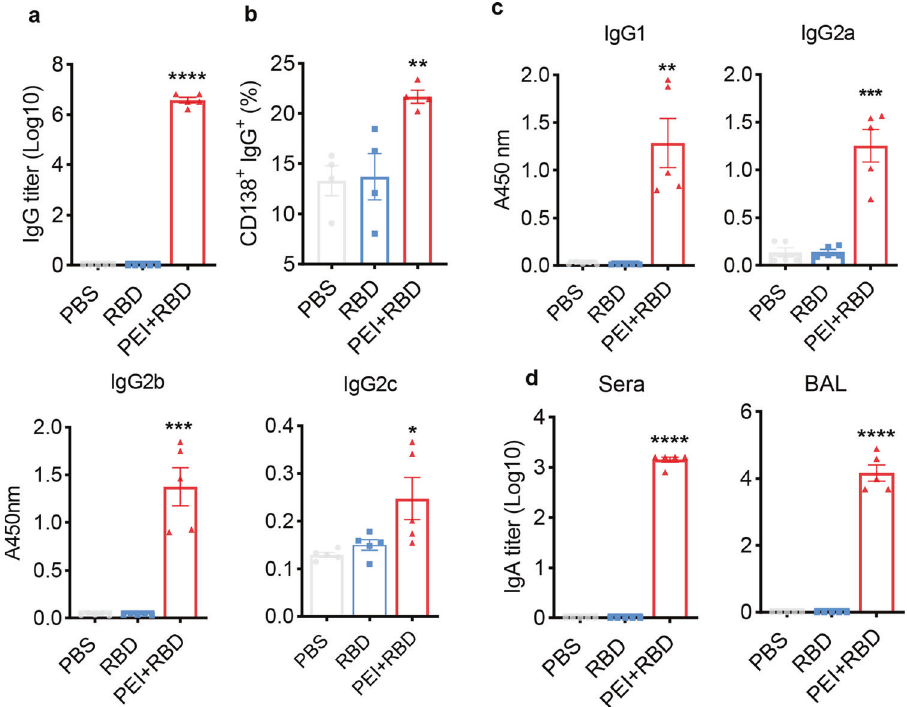
Fig. 1 Humoral responses in 1 year after intranasal immunization with RBD vaccine. NIH mice were intranasally immunized with PBS, RBD or PEI-adjuvanted RBD on days 0, 7, and 21. On day 365 after the fi rst dose, RBD-speci fi c antibodies in the serum and BALs were determined with ELISA. a RBD-speci fi c total IgG levels in the sera of immunized mice. b Frequency of IgG-secreting CD138 + long-lived plasma B cells in bone marrow of immunized animals on day 365, as determined by FCM. c Further analysis of RBD-speci fi c IgG isotypes in the serum, including IgG1, IgG2a, IgG2b, and IgG2c. d RBD-speci fi c IgA titers in the sera and BALs of immunized animals on day 365. All the data were presented as mean ± SEM. n = 4 – 5. P values were compared to PBS group (* P < 0.05; ** P < 0.01; *** P < 0.001; **** P <